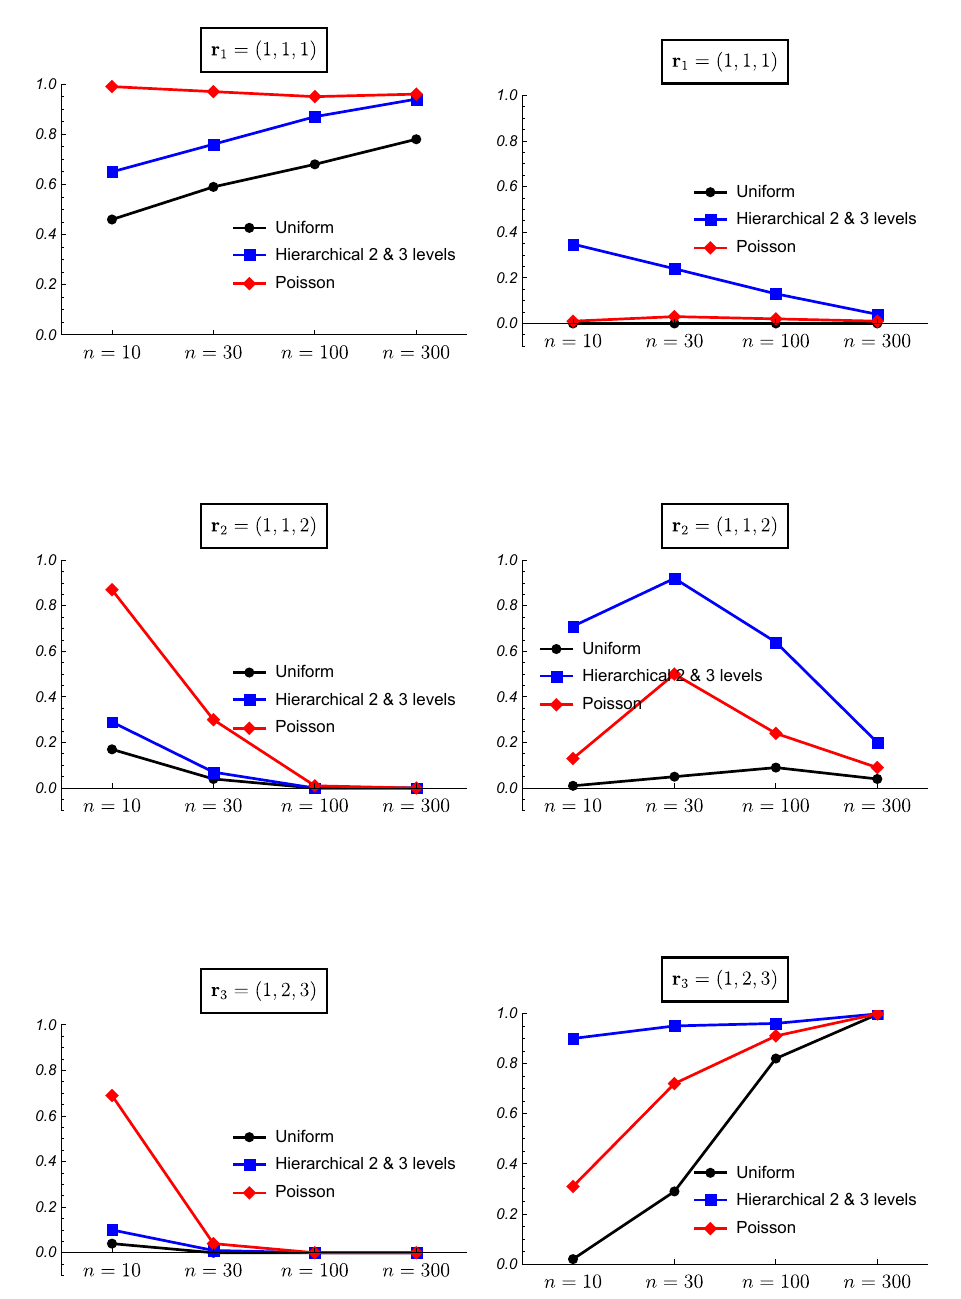
Figure 7. Frequentist validation for the case k = 3 and true partitions r 1 = ( 1,1,1 ) , r 2 = ( 1,1,2 ) and r 3 = ( 1,2,3 ) . ( Left column ) proportion of times the homogeneity case is found as the most probable. ( Right column ) proportion of times the heterogeneity case is found as the most